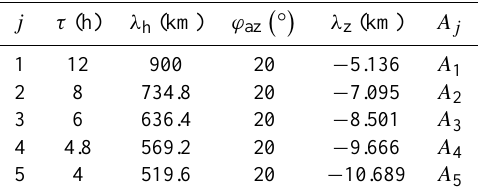
Table 2c. Same as Table 2a, but for identical azimuth